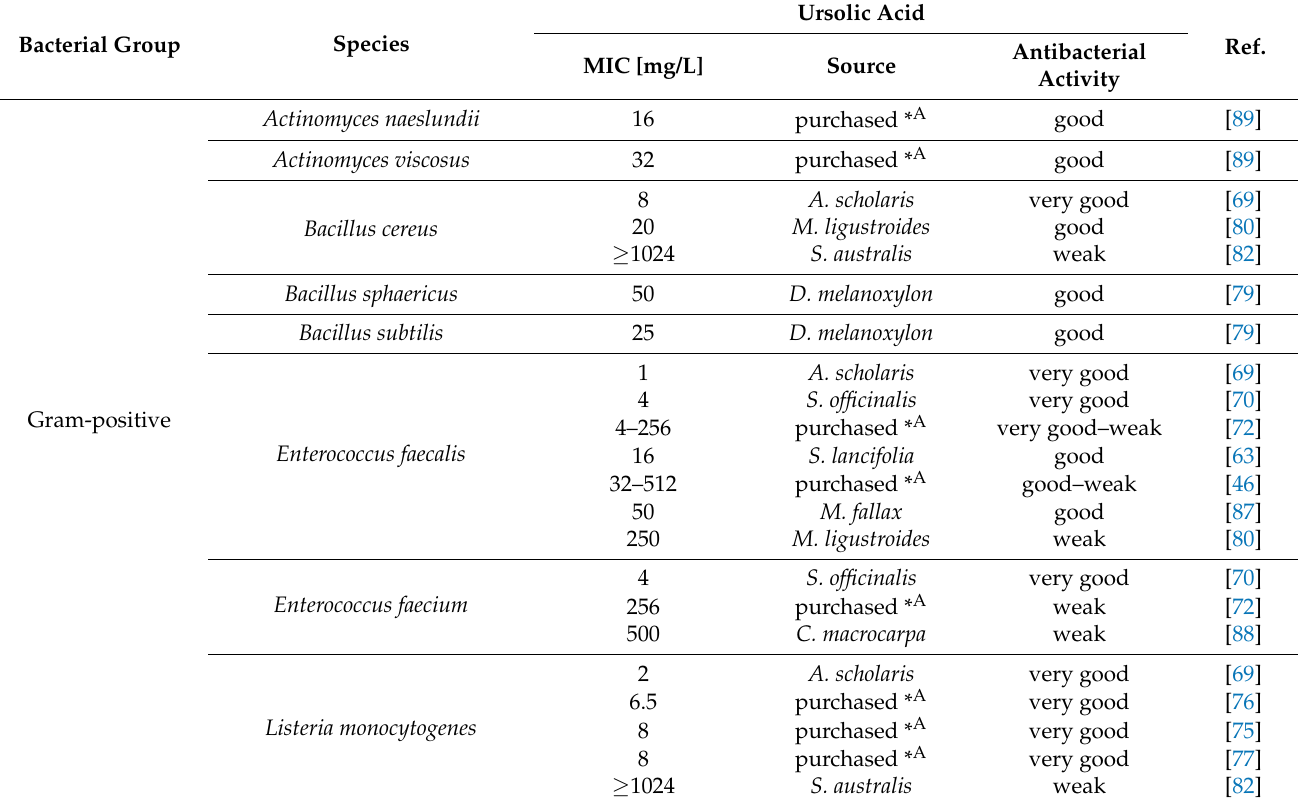
Table 3. MIC values of ursolic acid against Gram-positive and Gram-negative bacteria.